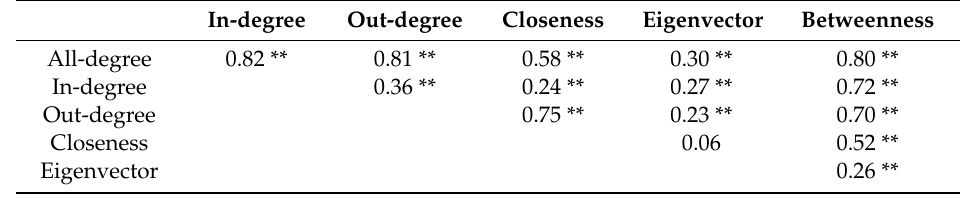
Table 4. Spearman rank correlations among individual scores for agonistic behaviour from a social network analysis. In-degree